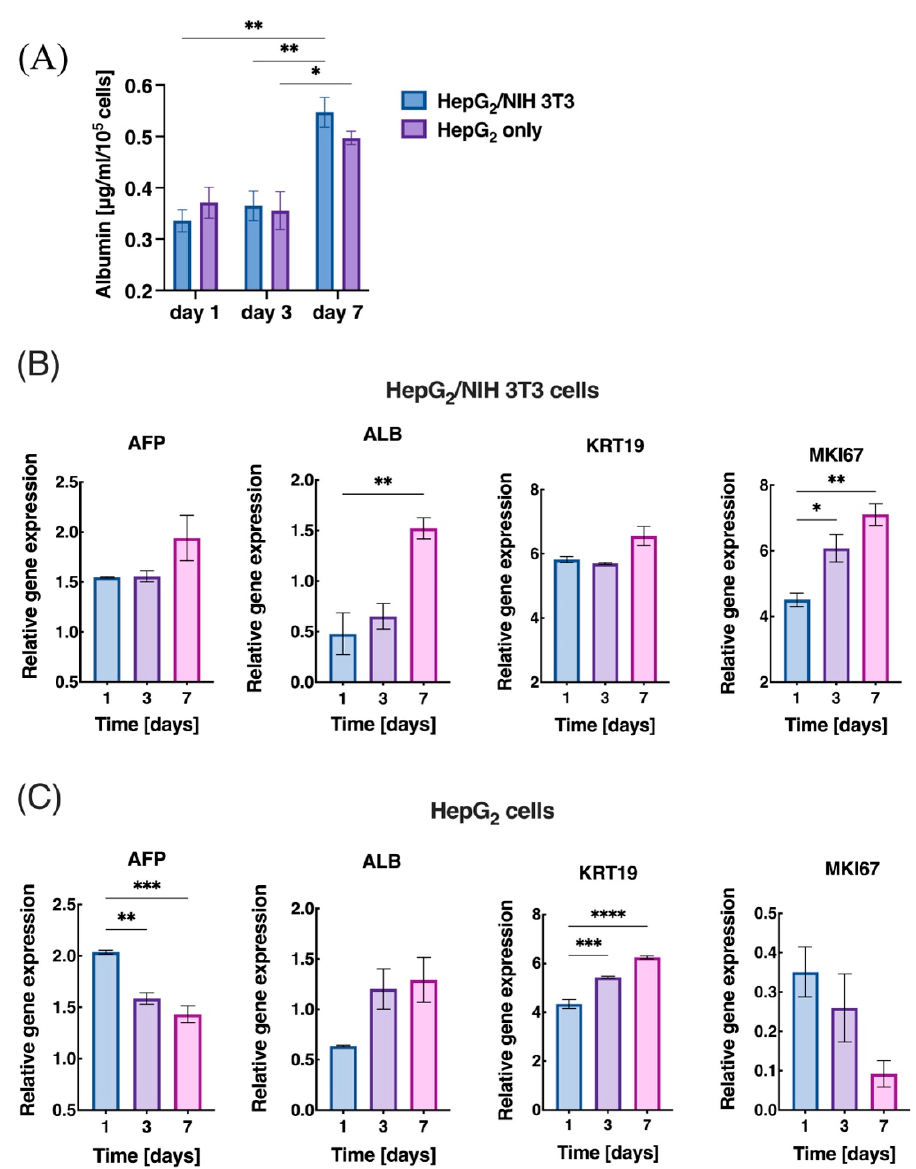
Figure 5. Expression of liver-specific functions in ( A ) co-culture of HepG 2 /NIH 3T3 cells compared to only HepG 2 cells with Albumin secretion in µ g/mL/10 5 cells ( n = 3, * p < 0.05 and ** p < 0.01) and gene expression analysis of ( B ) HepG 2 /NIH 3T3 cells ( n = 3, * p < 0.05 and ** p < 0.01) compared to ( C ) HepG 2 cells ( n = 3, ** p < 0.01, *** p < 0.001 and **** p < 0.0001) at day 1, 3, and 7 for liver-specific genes AFP, ALB, KRT19, and MKI67. Error bars represent the standard error of the mean.